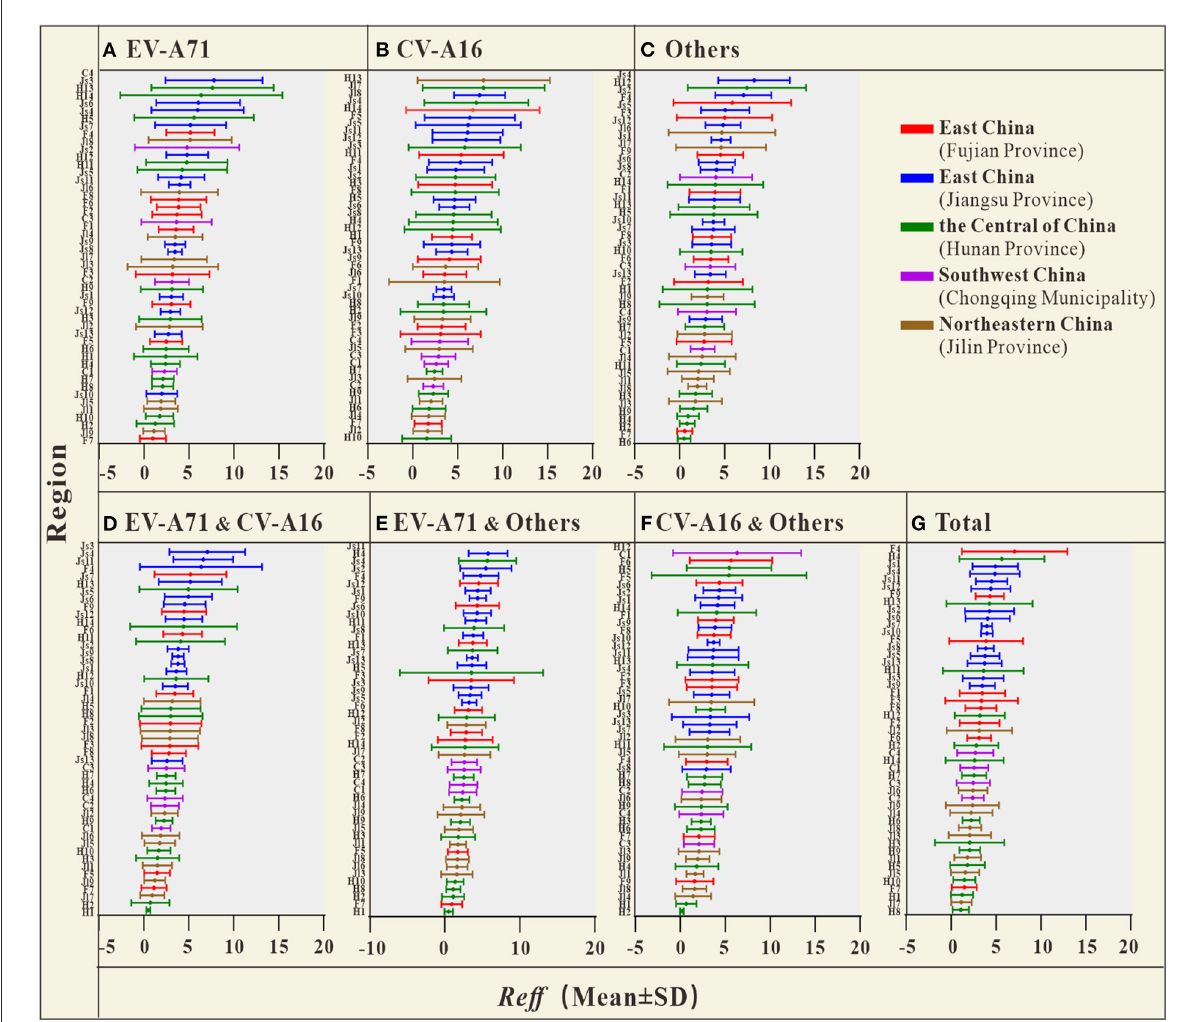
FIGURE3 The R eff of HFMD in each city, autonomous prefecture, and district [ (A) R eff average of EV-A71; (B) R eff average of CV-A16; (C) R eff average of Others; (D) R eff average of EV-A71&CV-A16; (E) R eff average of EV-A71&Others; (F) R eff average of CV-A16&Others; (G) R eff average of Total] (F1, Fuzhou City; F2, Xiamen City; F3, Putian City; F4, Sanming City; F5, Quanzhou City; F6, Zhangzhou City; F7, Nanping City; F8, Longyan City; F9, Ningde City; Js1, Nanjing City; Js2, Wuxi City; Js3, Xuzhou City; Js4, Changzhou City; Js5, Suzhou City; Js6, Nantong City; Js7, Lianyungang City; Js8, Huaian City; Js9, Yancheng City; Js10, Yangzhou City; Js11, Zhenjiang City; Js12, Taizhou City; Js13, Suqian City; H1, Changsha City; H2, Zhuzhou City; H3, Xiangtan City; H4, Hengyang City; H5, Shaoyang City; H6, Yueyang City; H7, Changde City; H8, Zhangjiajie City; H9, Yiyang City; H10, Chenzhou City; H11, Yongzhou City; H12, Huaihua City; H13, Loudi City; H14, Xiangxi Prefecture; C1, The central urban area of Chongqing; C2, The new area of Chongqing city proper; C3, The city cluster of three gorges reservoir area in northeast Chongqing; C4, The city cluster of Wuling mountain area in southeast Chongqing; Jl1, Changchun City; Jl2, Jilin City; Jl3, Siping City; Jl4, Liaoyuan City; Jl5, Tonghua City; Jl6, Baishan City; Jl7, Songyuan City; Jl8, Baicheng City; Jl9, Yanbian